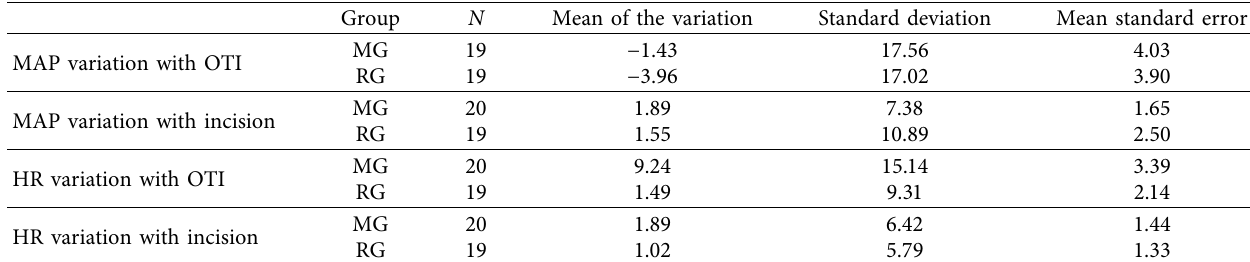
Table 2: Descriptive statistics for heart rate and mean blood pressure by the groups.